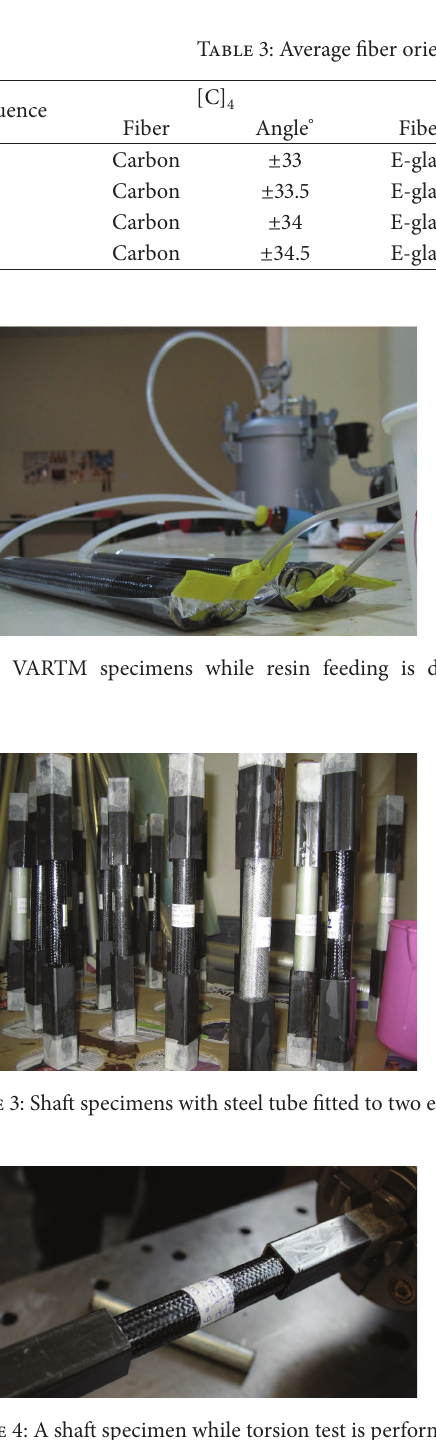
Figure 4: A shaft specimen while torsion test is performed.